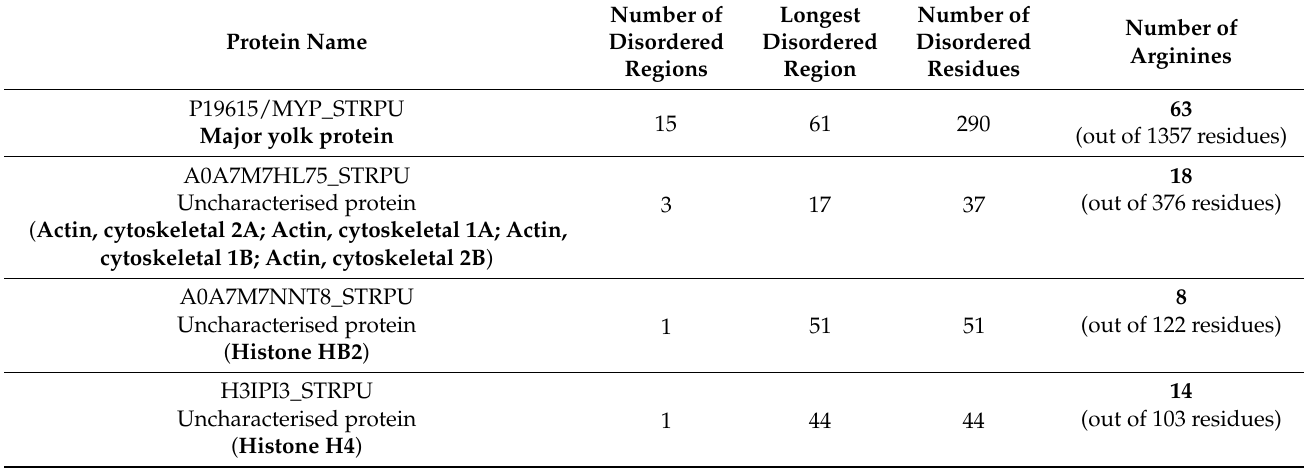
Figure 6. Deiminated protein hits and EV cargo and associated STRING protein network analysis of purple sea urchin coelomic fluid citrullinome and EV citrullinome, and of total EV protein cargo. ( A ) Venn diagram showing deiminated protein hits (“citrullinome”) identified in Strongylocentrotus purpuratus coelomic fluid and EVs, representing shared and unique proteins (uncharacterised proteins are indicated in brackets), identified using the Echinoidea UniProt database. ( B ) Venn diagram showing protein hits identified for total EV proteome cargo and deiminated EV cargo (EV citrullinome) protein hits. ( C ) Venn diagram showing KEGG and GO pathway analysis for deiminated proteins identified in coelomic fluid (coelomic fluid citrullinome) and EVs (EV citrullinome), respectively. ( D ) Venn diagram showing GO and KEGG pathways for total EV protein cargo and shared pathways with the EV citrullinome. The number of specific and overlapping pathways is indicated and relates to the STRING networks in Figures 2, 4 and 5. Table 3. FoldIndex© analysis of deiminated purple sea urchin proteins identified by F95 enrichment in EVs of sea urchin ( Strongylocentrotus purpuratus ). The number of disordered regions, residue length of the longest disordered region, total number of disordered residues, as well as the number of arginines present in the total number of residues for the individual protein hits are shown. Only protein hits with purple sea urchin are shown in this table; the proteins assessed are highlighted in